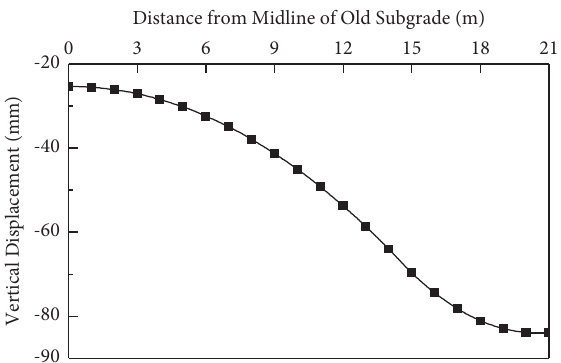
Figure 3: Vertical settlement cloud map.